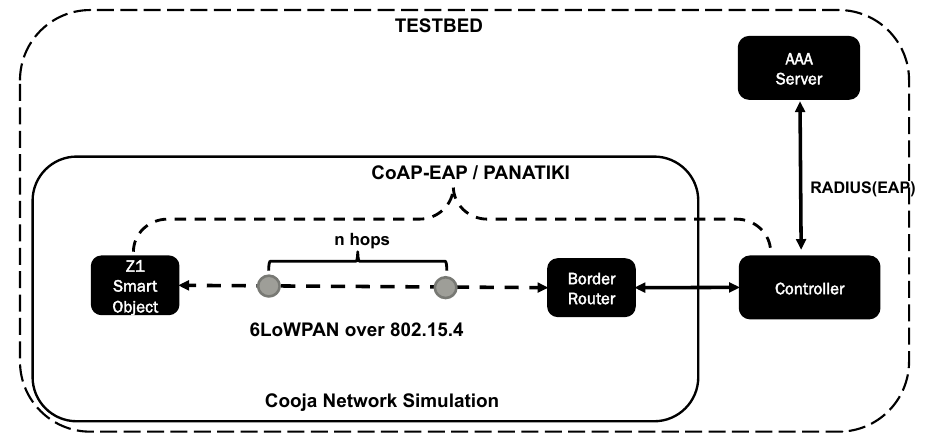
Figure 8. Testbed for the